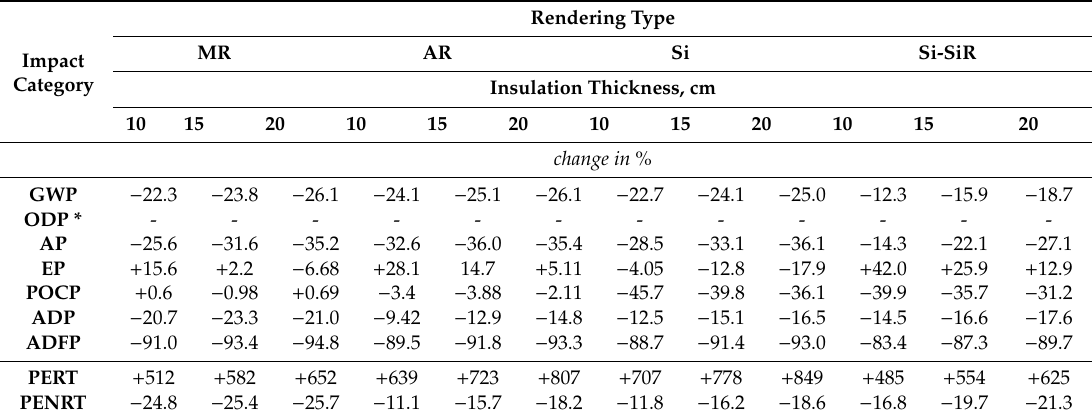
Table4. ThecomparisonofenvironmentalimpactcategoriesforETICSsystemswithdi ff